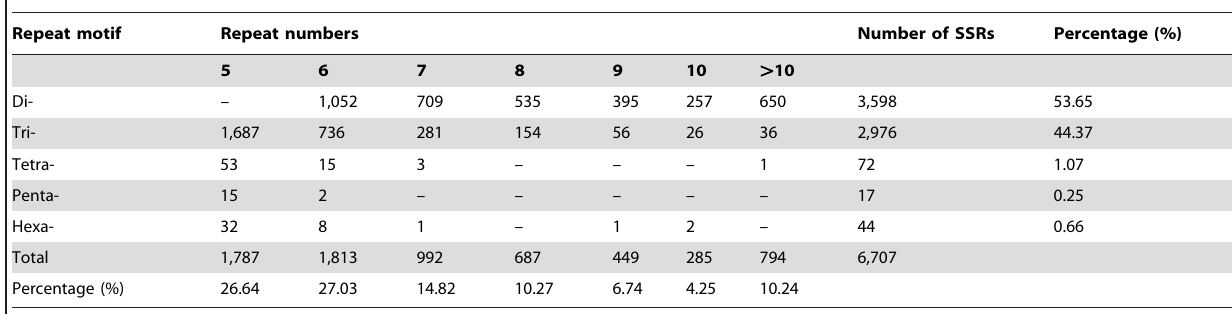
Table 6. Number of SSRs in yellow horn.